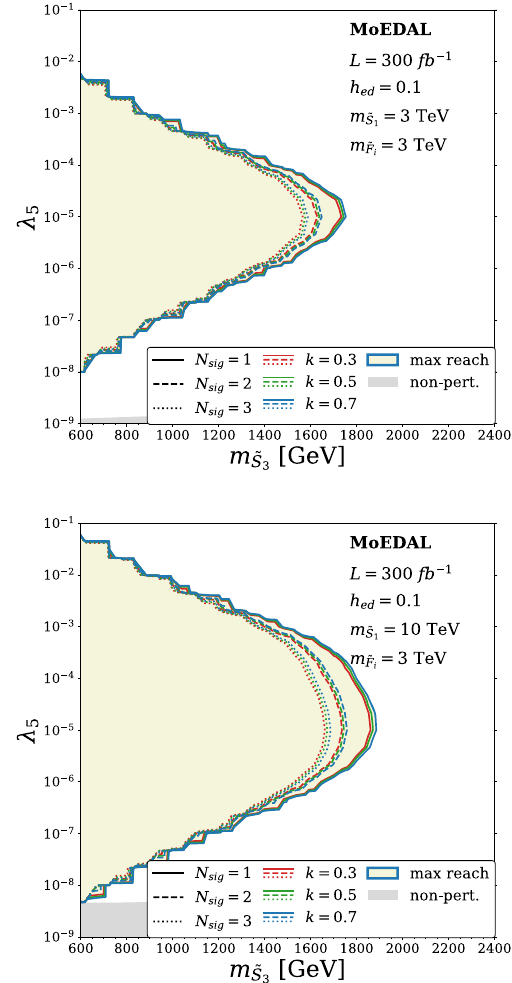
Fig. 11 MoEDAL’s detection sensitivity for Model-2 in the ( m S λ 5 ) plane. The red, green and blue contours correspond to the results obtained with the hadronisation parameter k = 0 . 3, 0.5 and 0.7, respec- tively. In the regions inside the solid, dashed and dotted contours, MoEDAL expects to observe more than 1, 2 and 3 events, respectively. The region with N sig ≥ 3 will be excluded at 95% CL if MoEDAL does